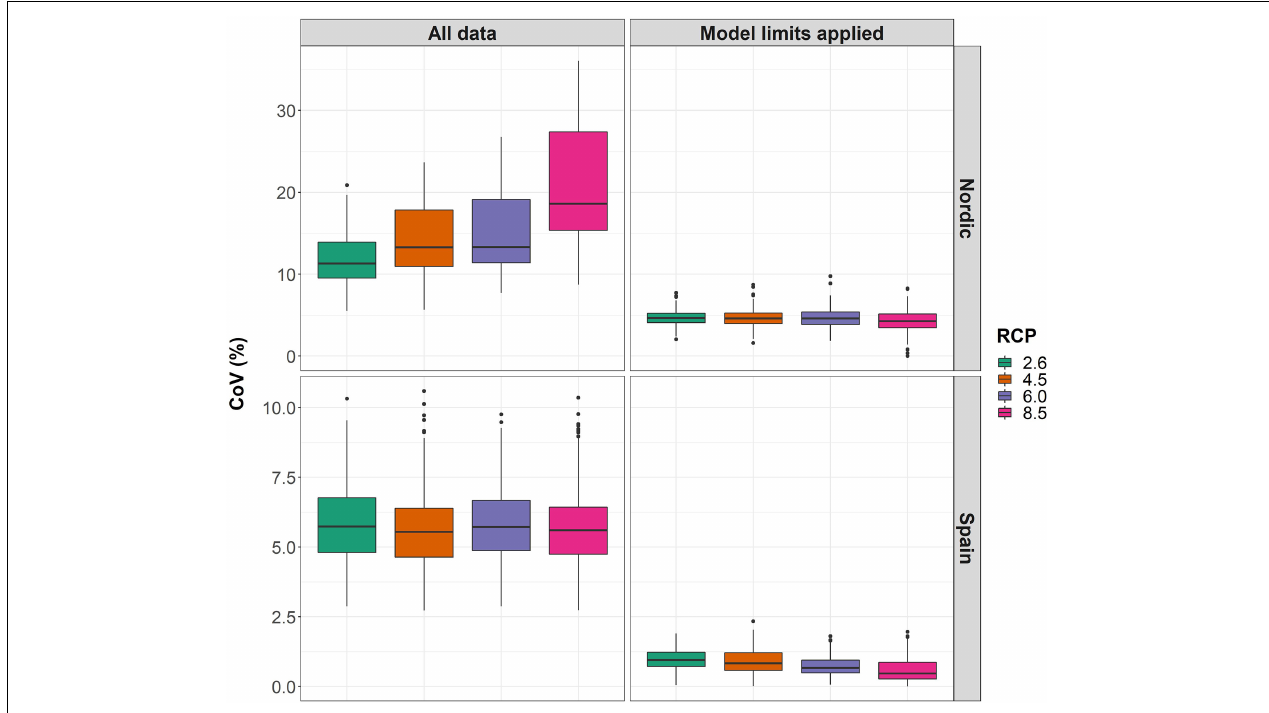
FIGURE 5 | Coefficients of Variation (CoV) calculated for Scots pine tree height predictions across the Nordic and Spain study areas respectively where the standard deviation of ensemble mean height predictions per RCP are given as a percentage of the 1961–1990 average height. On the left half of the figure CoV-calculations using all height prediction data is shown whereas for CoV-calculations made only from areas within the respective data ranges used for model development on the right